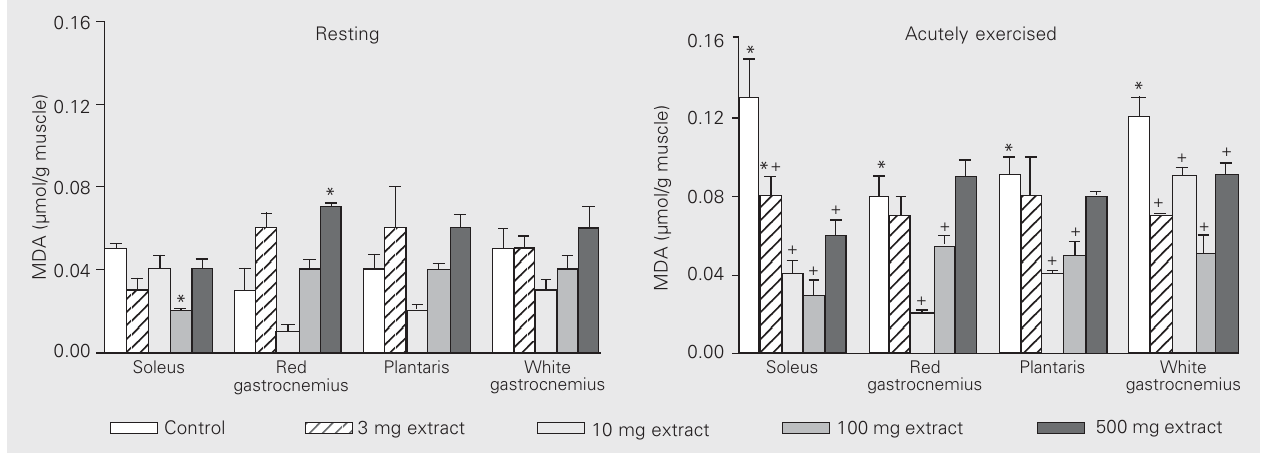
Figure 1. Lipid peroxidation content indirectly measured by the production of malondialdehyde (MDA) in hindlimb muscles from resting and exercised animals supplemented with 3, 10, 100, and 500 mg/kg ginseng extract by gavage. Data are reported as means ± SD µmol MDA/g muscle for muscle from 8 rats. *P < 0.05 compared to resting control group. + P < 0.05 compared to exercised control group (Newman-Keuls